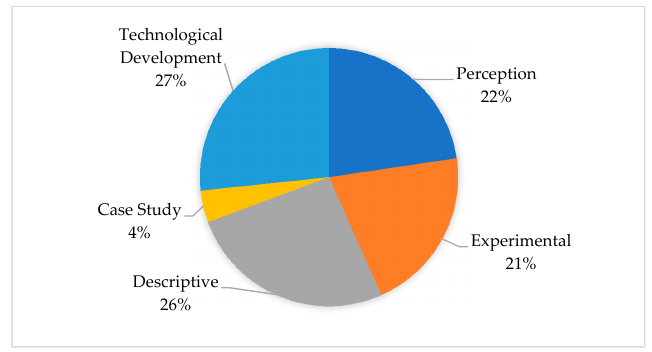
Figure 4. Type of studies in selected papers.